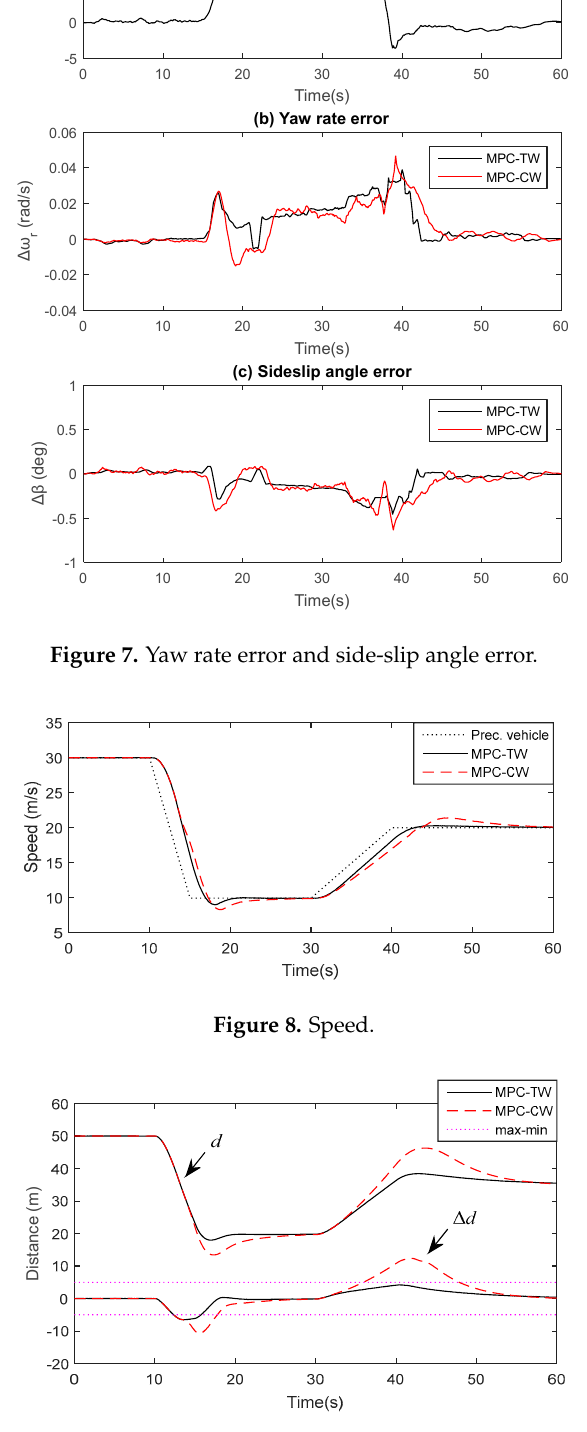
Figure 9. Actual inter-vehicle distance and distance error.